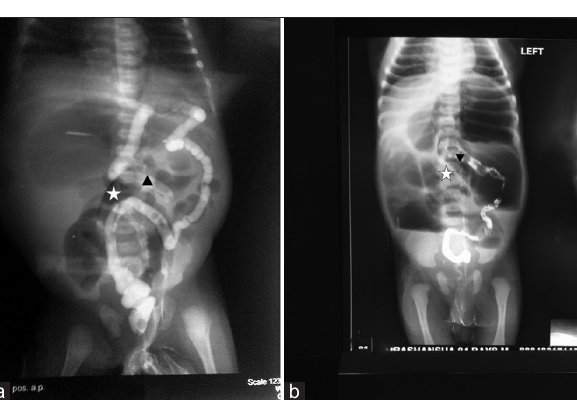
Figure 3: (a) The right half of transverse colon (black triangle) is bent back on itself to form a “Hook” by the adjacent ascending colon loop. Case of Type IIIa atresia at hepatic flexure (white star), (b) transverse colon is seen to turn back on itself (black triangle) to form a “hook or a hairpin shape” by adjacent dilated ileal loops (white star). Case of Type